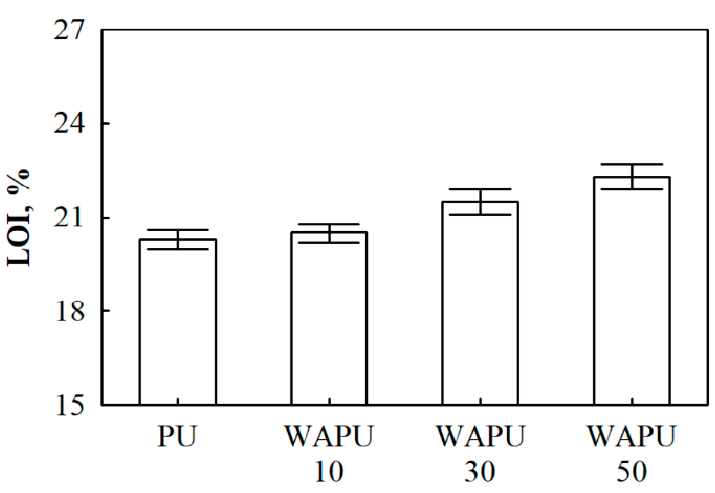
Figure 4. Limited oxygen index (LOI) test for PU and WAPU foams.